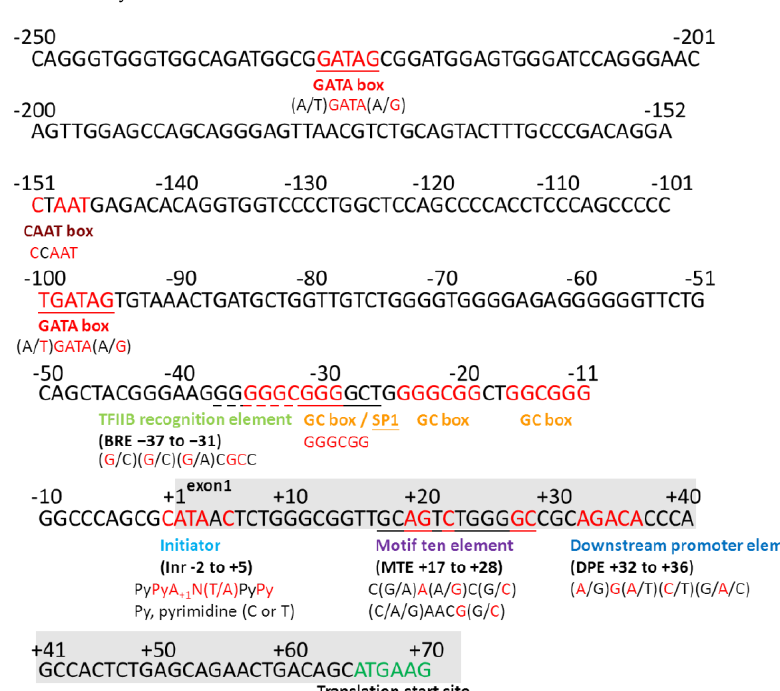
Figure 1. Illustration of the plasmid construction of human microfibrillar-associated protein 4 ( MFAP4 ) promoter in this study.